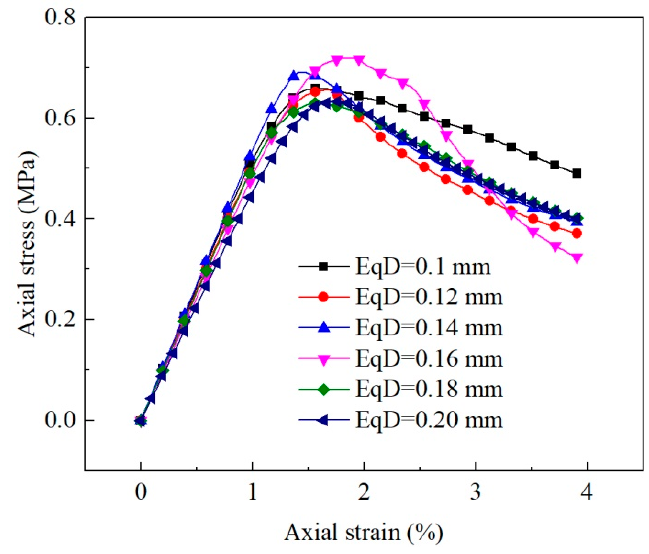
Figure 8. Macroscopic static response of equivalent diameter of pores.